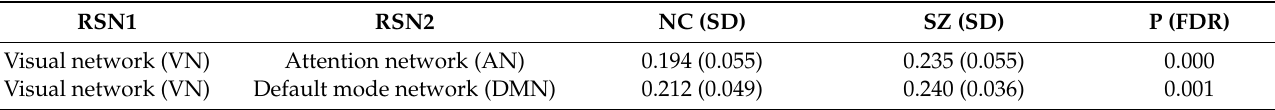
Table 4. RSN-to-RSN integration scores with significant differences in slow3 (0.073–0.198 Hz).